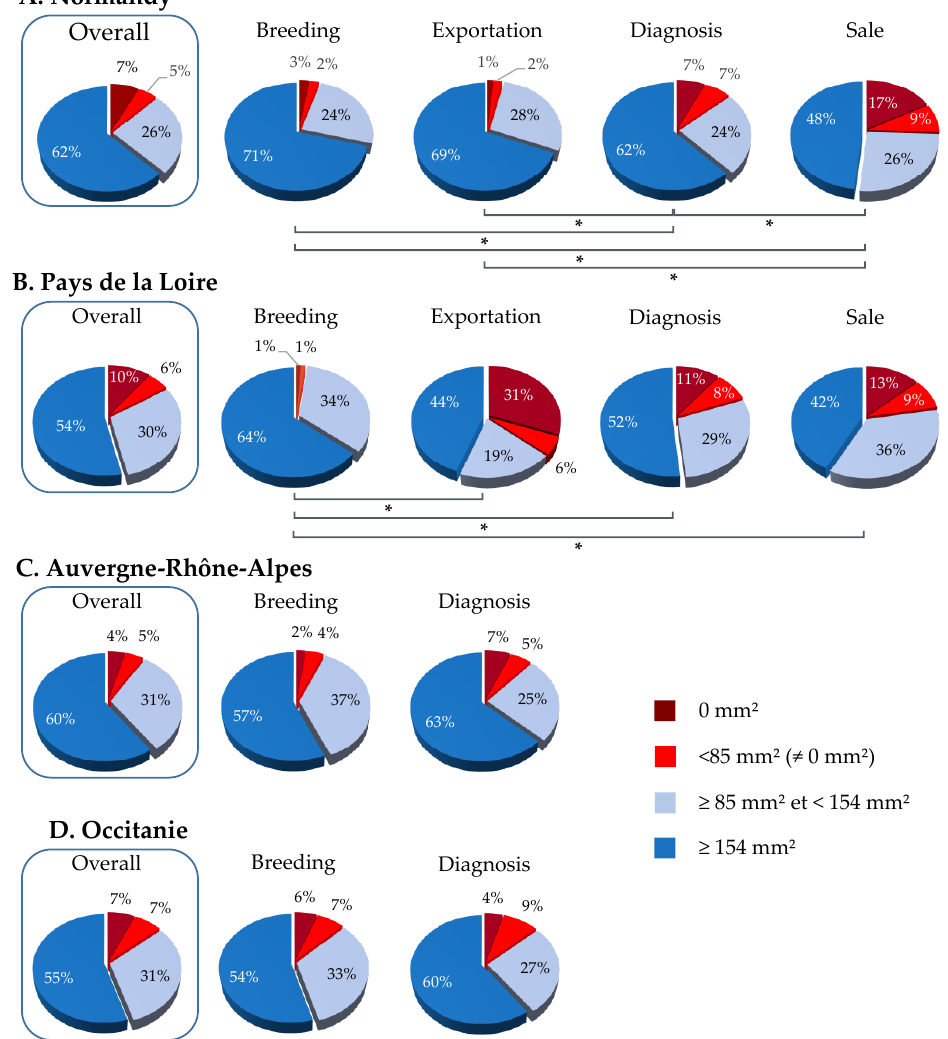
Figure 2. SRH antibody responses obtained from different geographical regions in France. Overall and categories analysis of immune coverage for Normandy ( A ), for Pays de la Loire ( B ), for Auvergne-Rhône-Alpes ( C ) and for Occitanie ( D ). SRH titers below the clinical protection threshold (>85 mm²) are in red colors, titers above the clinical protection threshold are in light blue (85 mm² and >154 mm²), titers above the clinical and virus shedding protection threshold (154 mm² and above) are in blue. (*) p -value ≤ 0. 0001.